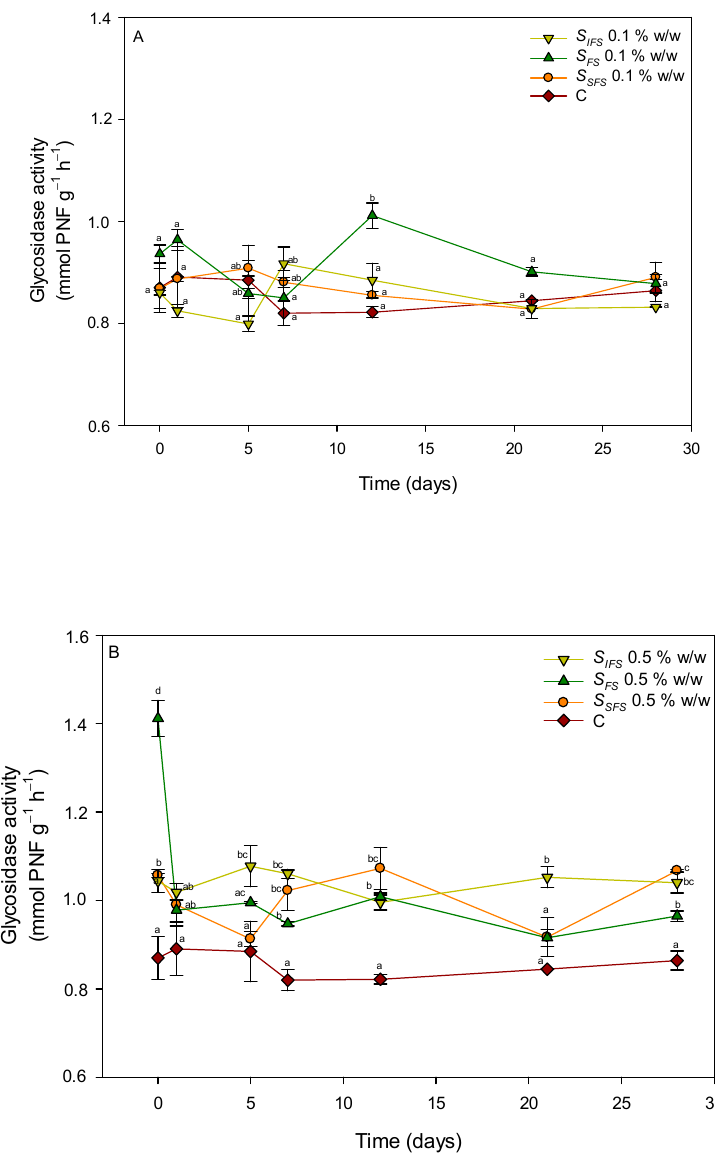
Figure 5. The glucosidase activity in the control soils and those treated with the different products at concentrations of 0.1% w / w ( A ) and 0.5% w / w ( B ). Points (mean ± SD) with the same letter(s) were not significantly different from each other ( p > 0.05); only the points of each test time were compared with each other. PNF: p-nitrophenol.